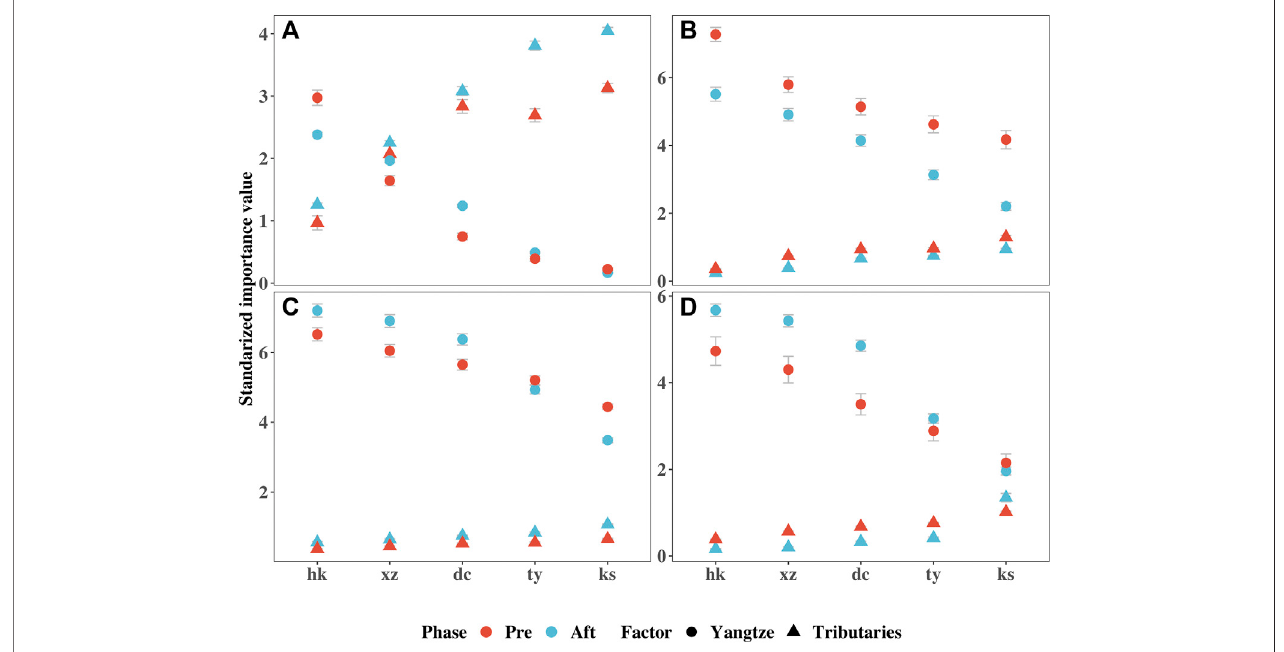
FIGURE 4 | Relative importance of the Yangtze River and local tributaries on the water level across the fi ve gauging stations and two phases for the (A) dry, (B) rising, (C) wet, and (D) recession seasons.